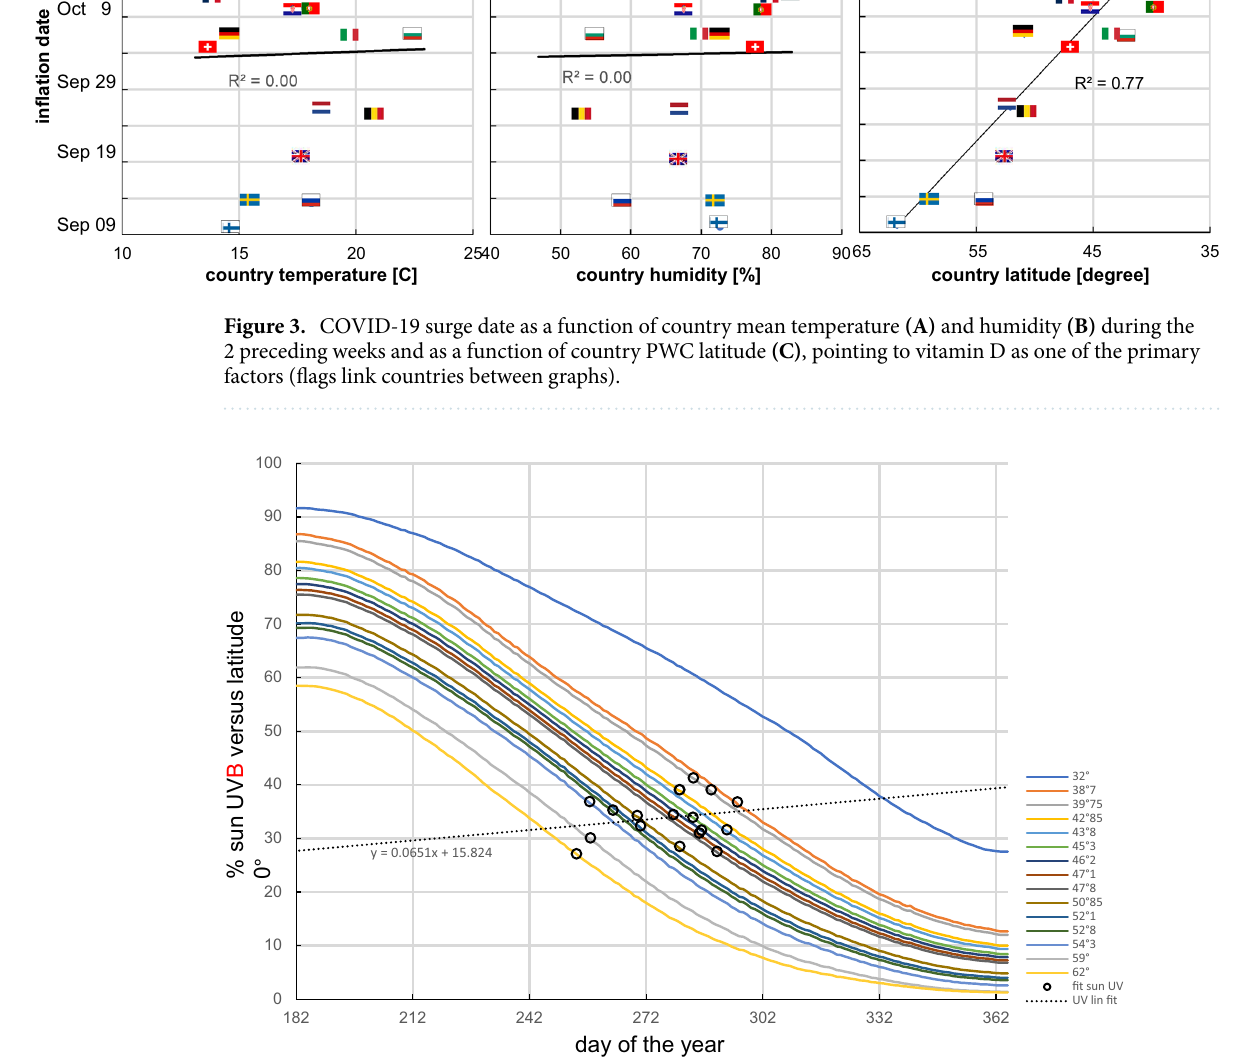
Figure 4. Solid curves: theoretical sun UVB daily dose for vitamin D skin production under a clear sky corresponding to the 18 PWC country latitudes plus the 31° latitude (derived from Fig. 1B in 1 ). Black circles: country surge dates positioned on their corresponding latitude